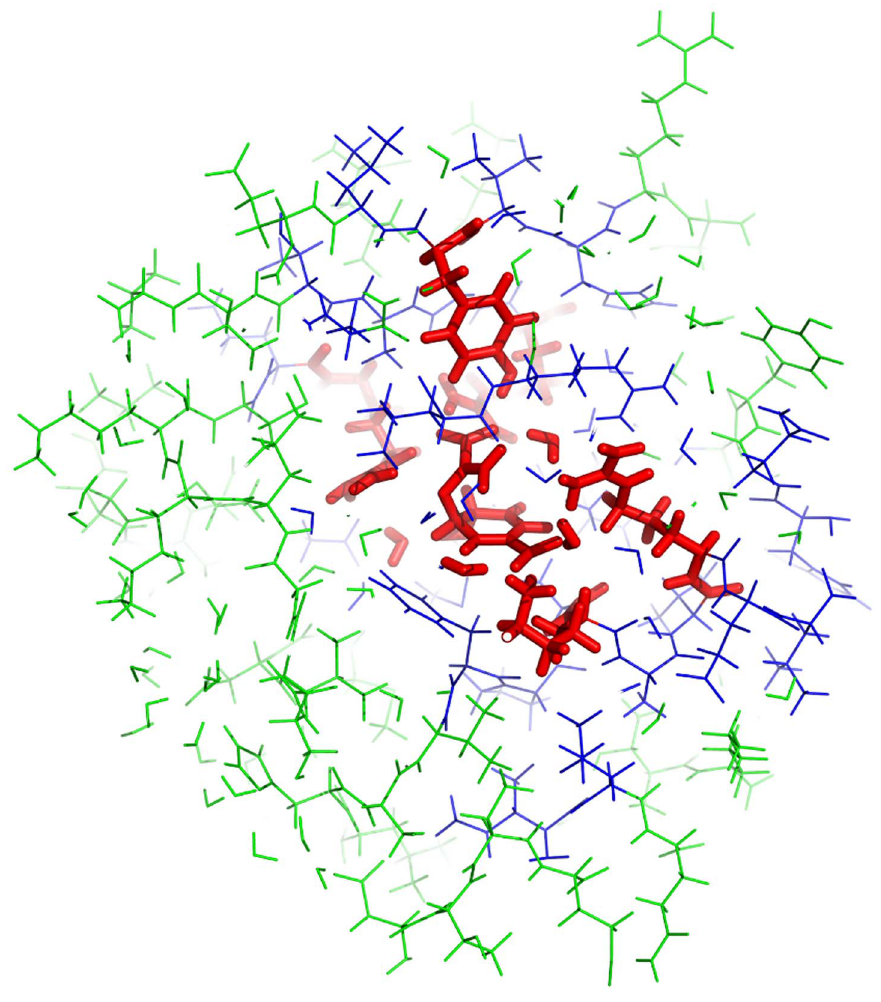
Figure 4. EFMO:S model of chorismate mutase used in this study. The entire model contains 2398 atoms. There are 1341 atoms in green belonging to the frozen region ( F ), 928 atoms in blue belonging to the buffer region ( b ) and 129 atoms in red belonging to the active region ( A ).